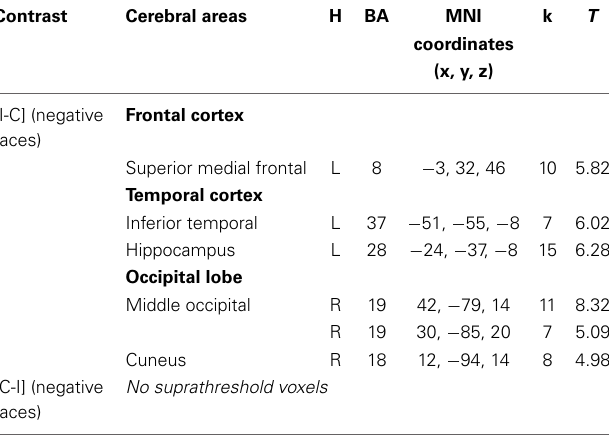
Table 5 | Brain regions activated during the emotional Stroop task when only positive faces are analyzed in healthy subjects.